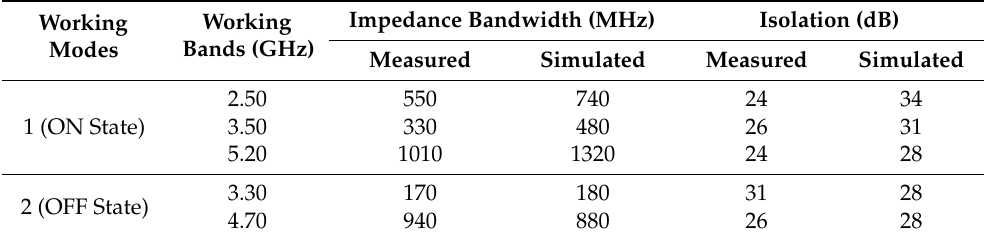
Figure 6. Scattering parameters of the MIMO antenna for modes-1 and -2. Table 2. Summary of the measured and simulated